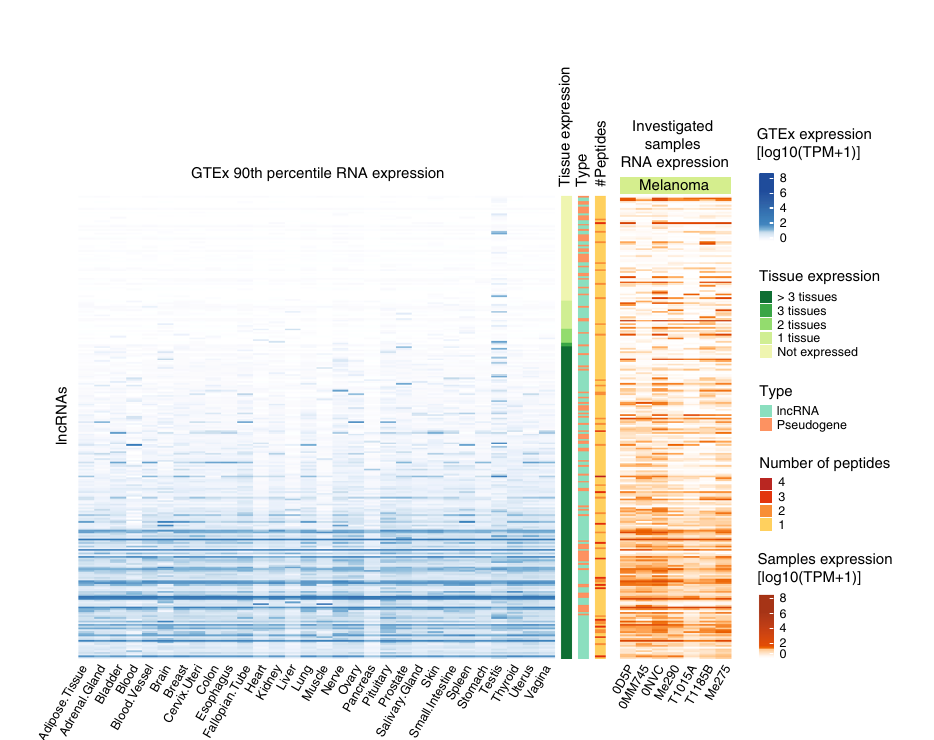
Fig. 5 scRNA-Seq reveals non-coding transcriptional heterogeneity in melanoma 0D5P. a t-SNE plot of the 1365 cells colored by their “ cell cycle ” scores. b Examples of cell cycle dependent genes: ATAD2 , a tumor-associated antigen, and c TMEM106C , from which a noncHLAIp originated. d Genes of interest were plotted based on their sum normalized expression by scRNA-Seq and ordered based on the percentage of cells that expressed the gene. The color codes denote the type of HLAIp identi fi ed from those genes. e t-SNE plot of the 1365 cells colored by the fi ve identi fi ed clusters. Clusters were annotated based on functional enrichment analyses of marker genes. f t-SNE plot highlighting the expression of the ABCB5 gene enriched in cluster 0. g Heatmap showing the scaled and centered expressions of marker genes in cluster 0. The cluster colors from e are represented above the plot. h Expression pro fi les of four marker genes in cluster 0 over all other clusters, including two well-known cancer biomarkers, MITF and CTNNB1 , and two source genes for which noncHLAIp were identi fi ed, the ABCB5 gene with a dORF and LINC00520 . The p -values represented in b , c , and h were obtained with Wilcoxon tests. Source data are provided as a Source Data fi le.